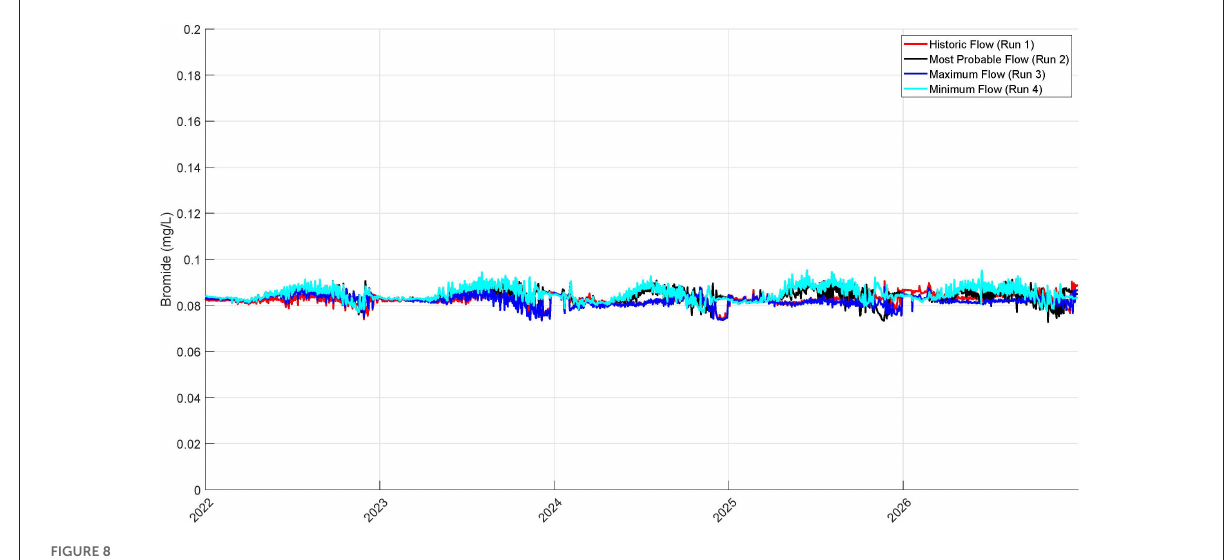
FIGURE8 Projected raw water bromide at Intake 3.